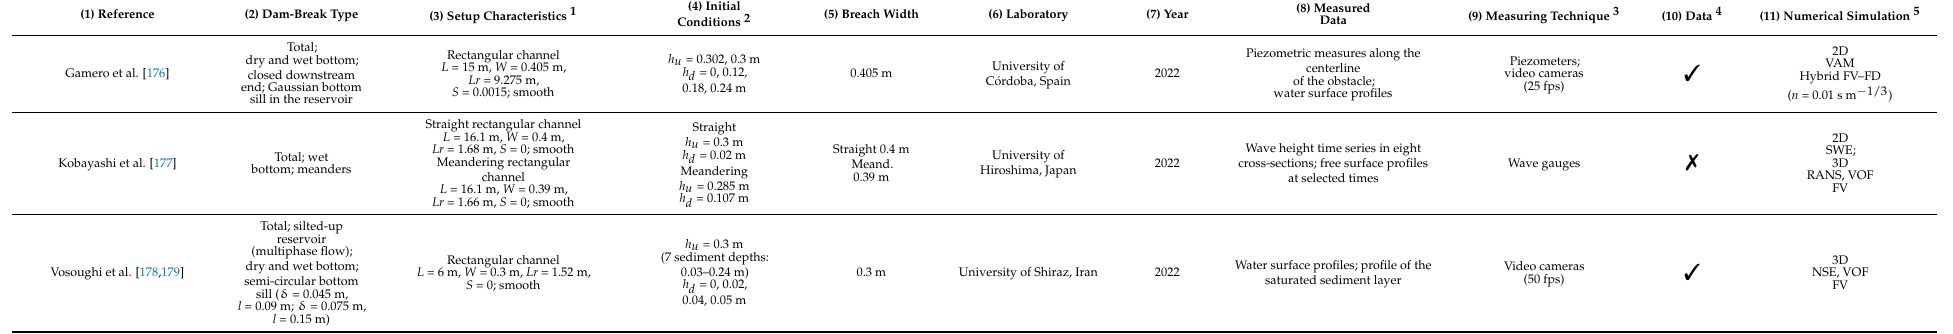
Table 1. Basic experimental investigations of fundamental dam-break wave physical characteristics.